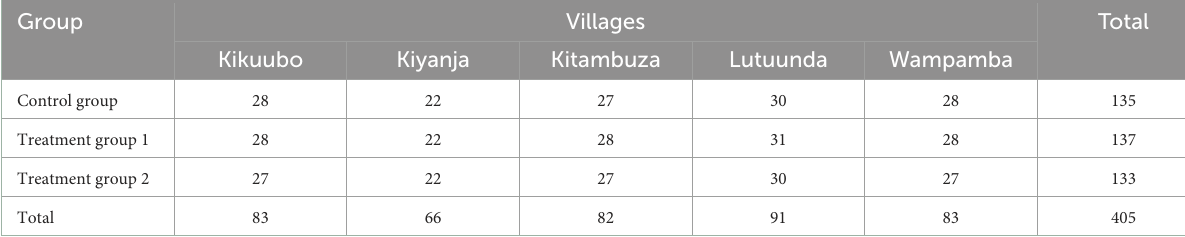
TABLE 1 Distribution of households in the intervention according to five villages/zones of Kanyanya. Group